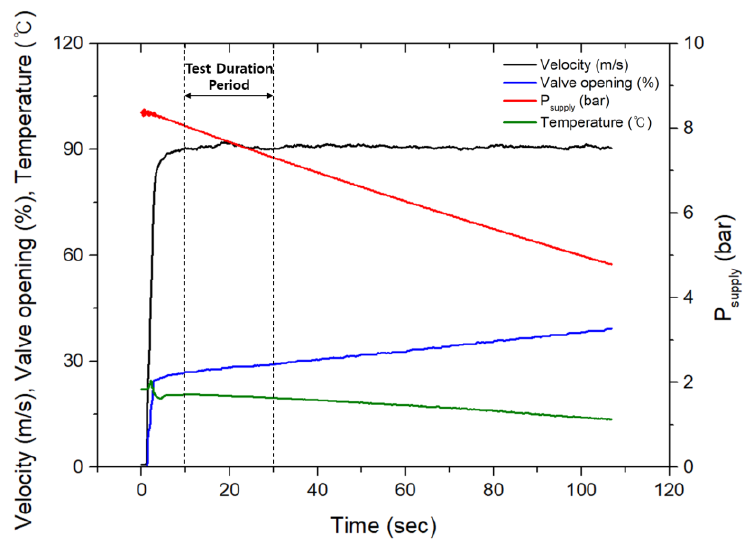
Figure 3. Velocity, pressure, temperature, and valve opening during the test.